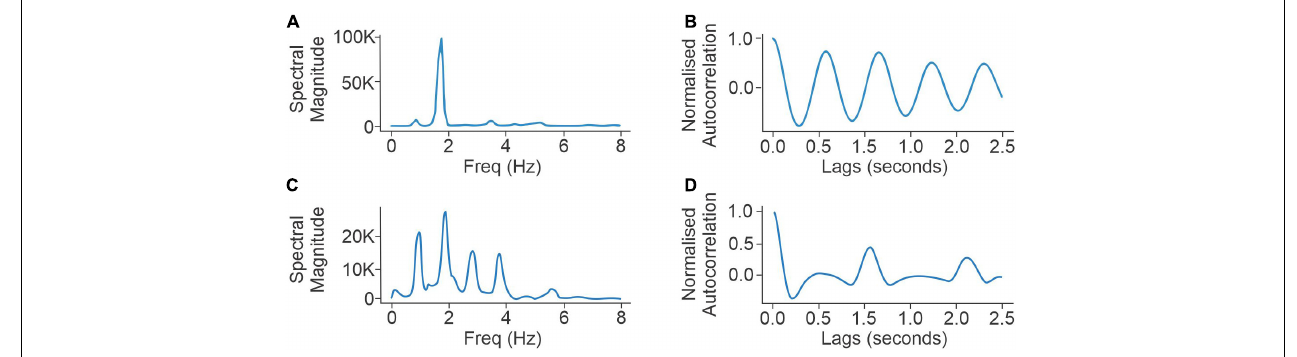
FIGURE 1 | Panels (A,B) compare the spectral densities ( left ) and autocorrelation function ( right ) of a normal walker with low scores for UPDRS III questions for axial rigidity (UPDRS III 3a–3e = 2), postural stability (UPDRS III 3.10-12 = 1), UPDRS III (overall) (=20), and low FoG score (=5). Panels (C,D) compare the spectral densities ( left ) and autocorrelation function ( right ) of an abnormal walker with high responses to UPDRS III questions for axial rigidity (UPDRS III 3a–3e = 11) and postural stability (UPDRS III 3.10-12 = 4), UPDRS III (overall) (48), and high FoG score